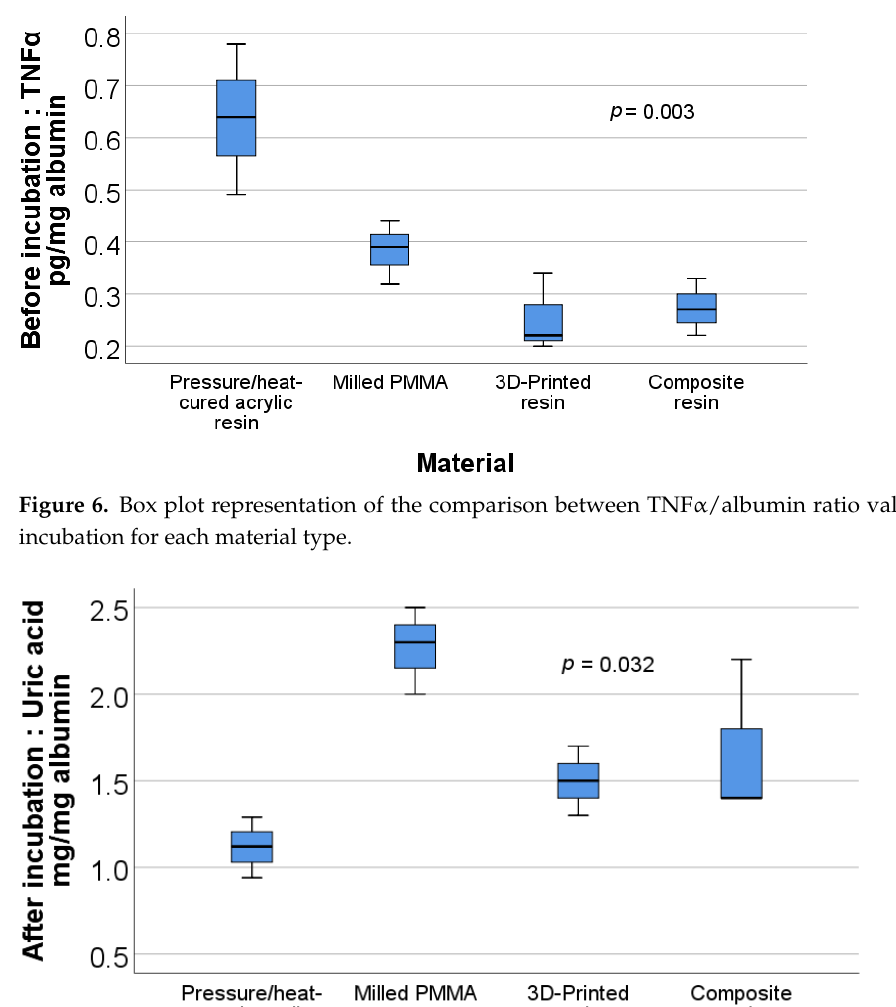
Figure 7. Box plot representation of the comparison between uric acid/albumin ratio values—after incubation for each material incubation for each material type.